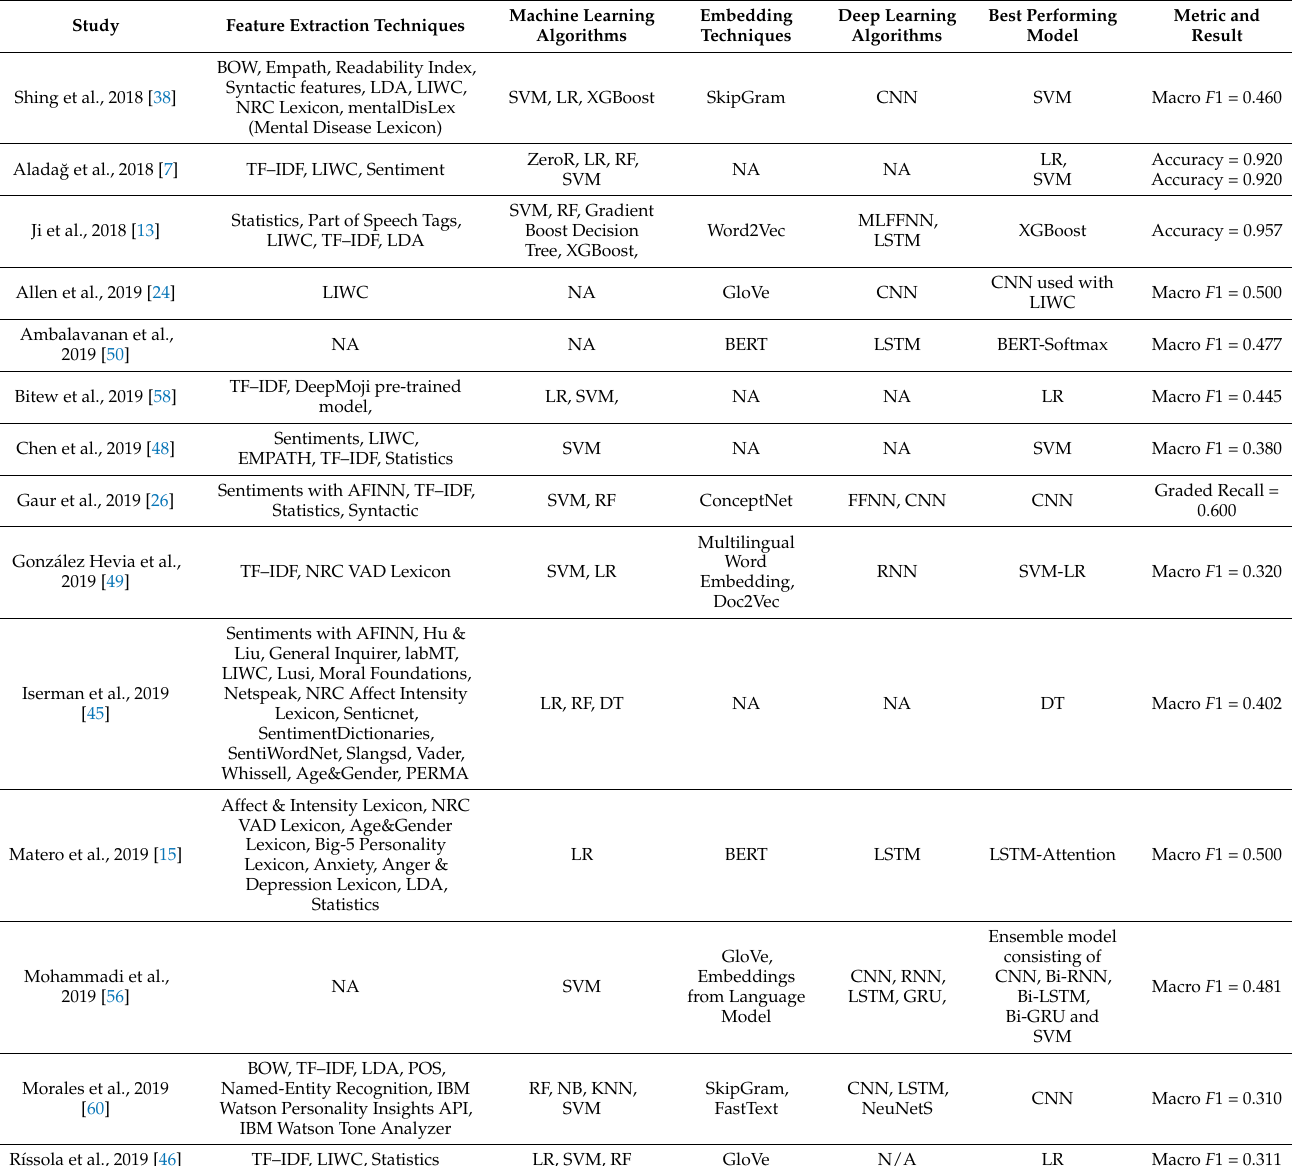
Table 2. Summary of machine learning and natural language processing